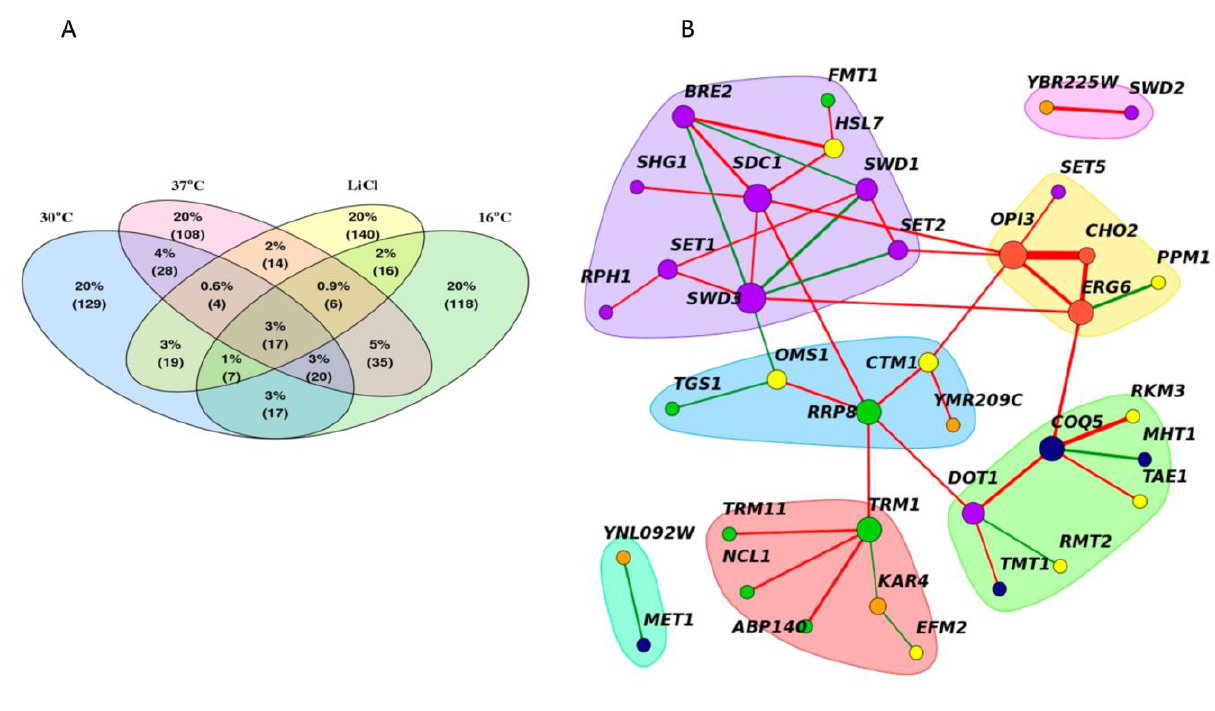
FIGURE 6: A core methyltransferase network. (A) Venn diagram of the shared significant interactions between all four conditions (30°C, 16°C, 37°C or LiCl). (B) The core methyltransferase genetic network shared by at least three of the four conditions tested. Red and green edges denote negative and positive genetic interactions, respectively. Line width represents average genetic interaction strength. Node color represents biological substrate; purple (histone), green (RNA), yellow (small molecule), red (lipid), orange (unknown) and navy (small molecule). Distinct groups were identified by clustering edge